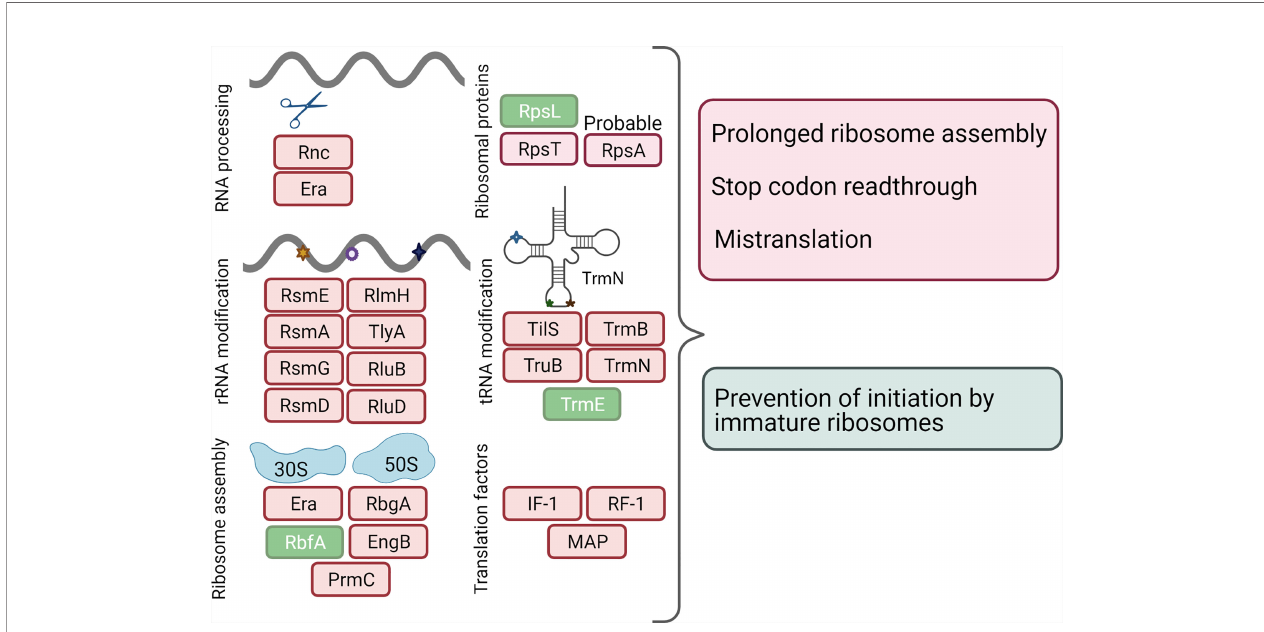
FIGURE 5 | Response of translation apparatus to a change in the energy source. The down-regulated proteins are indicated in red, up-regulated - in green. The corresponding full names of proteins are given in Supplementary Tables S3 , S4